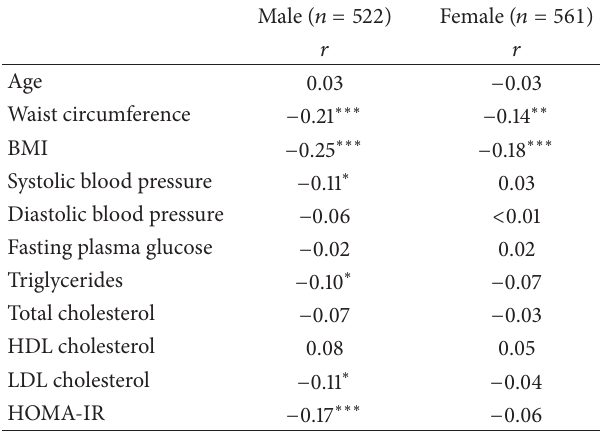
Table 3: Spearman correlation coefficient of cardiometabolic vari- ables associated with sRAGE.